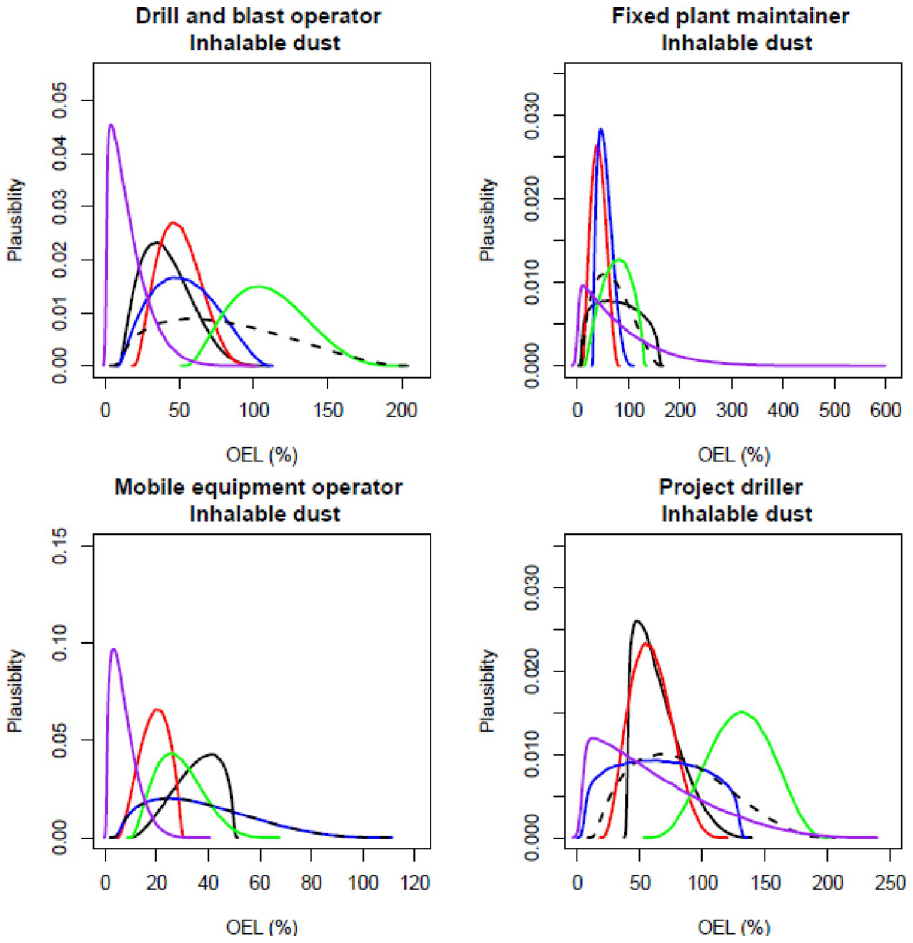
Fig 4. Expert estimates and measured data of inhalable dust percentage of occupational exposure limit (OEL). Each curve depicts the experts support (probability density) or measured data encoded into a scaled Beta distribution. Experts are denoted in the colours blue, red, black and green; combined experts are the dashed line. Measured data is presented as